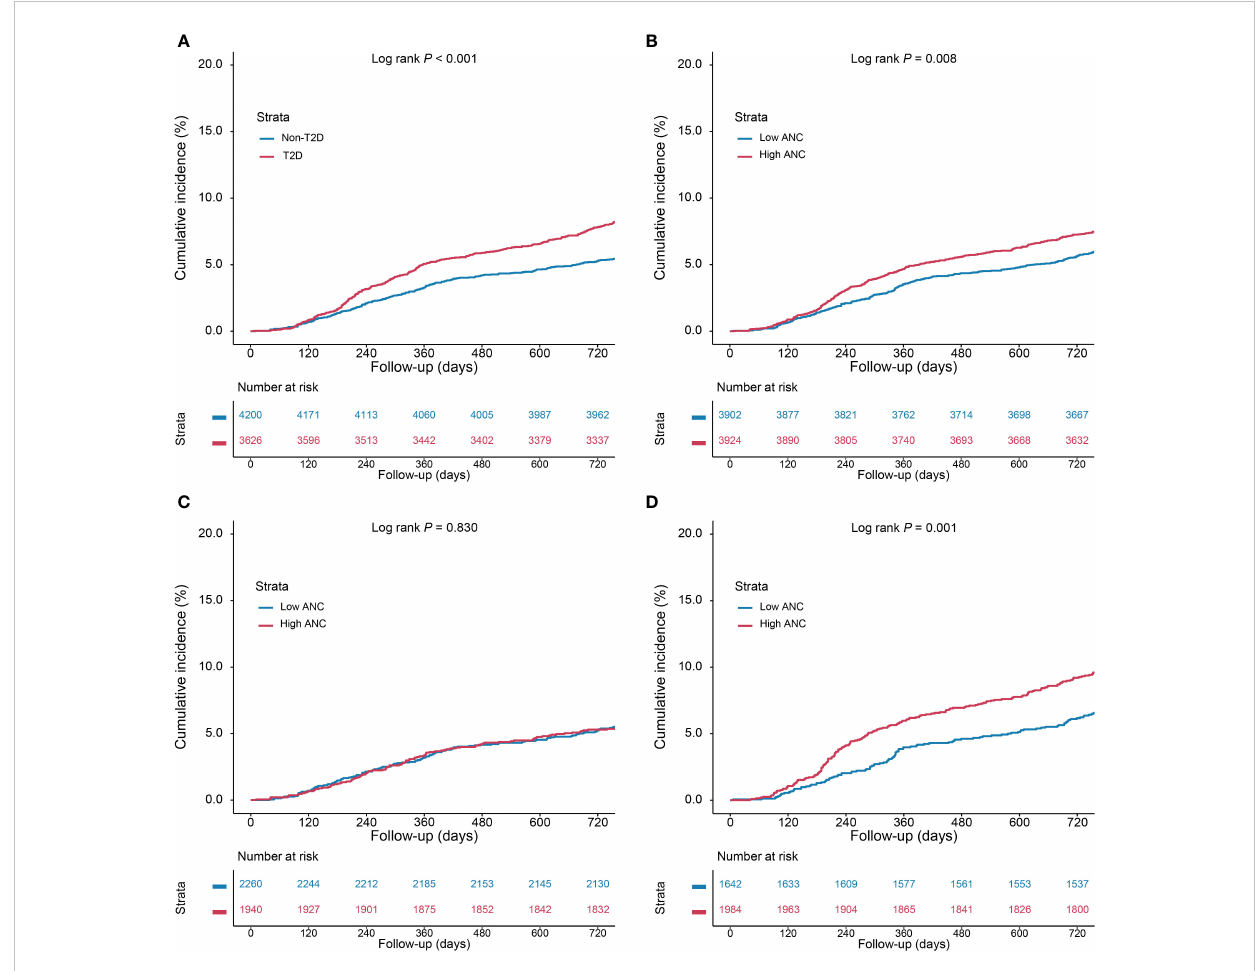
FIGURE 2 Kaplan – Meier (KM) curves for cumulative incidence of MACCEs. (A) KM curves according to type 2 diabetes, (B) KM curves according to ANC categories, (C) KM curves according to ANC categories in non-diabetic patients, and (D) KM curves according to ANC categories in diabetic patients. Abbreviations as in Figure